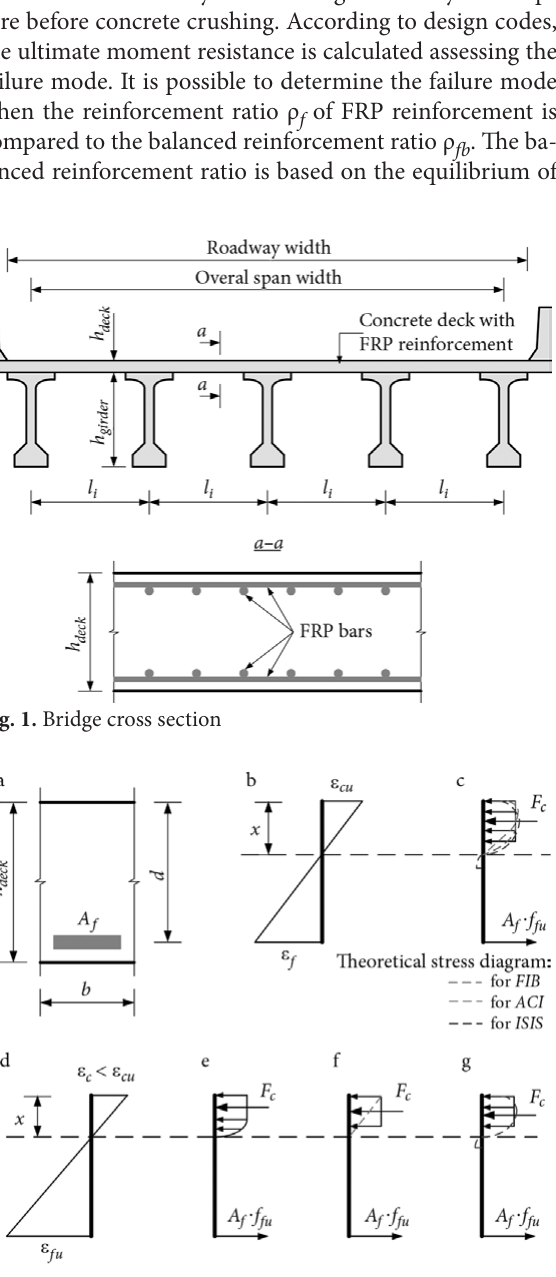
Fig. 2. Design scheme: a – deck cross section; b –